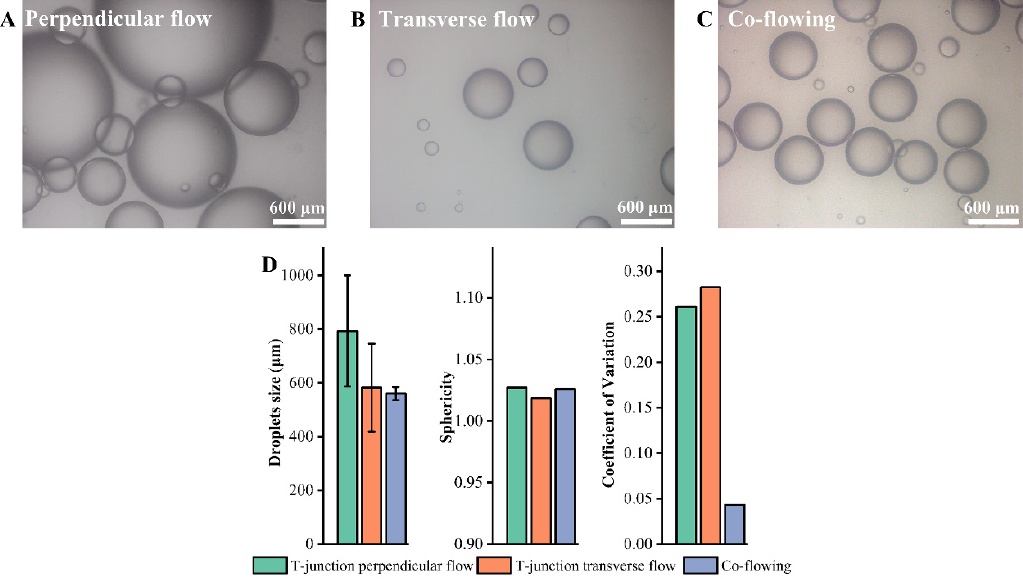
Figure 3. ( A ) T-junction perpendicular flow. ( B ) T-junction transverse flow. ( C ) Co-flowing. ( D ) Droplets’ sizes and sphericity and coefficient of variation by the three structures.